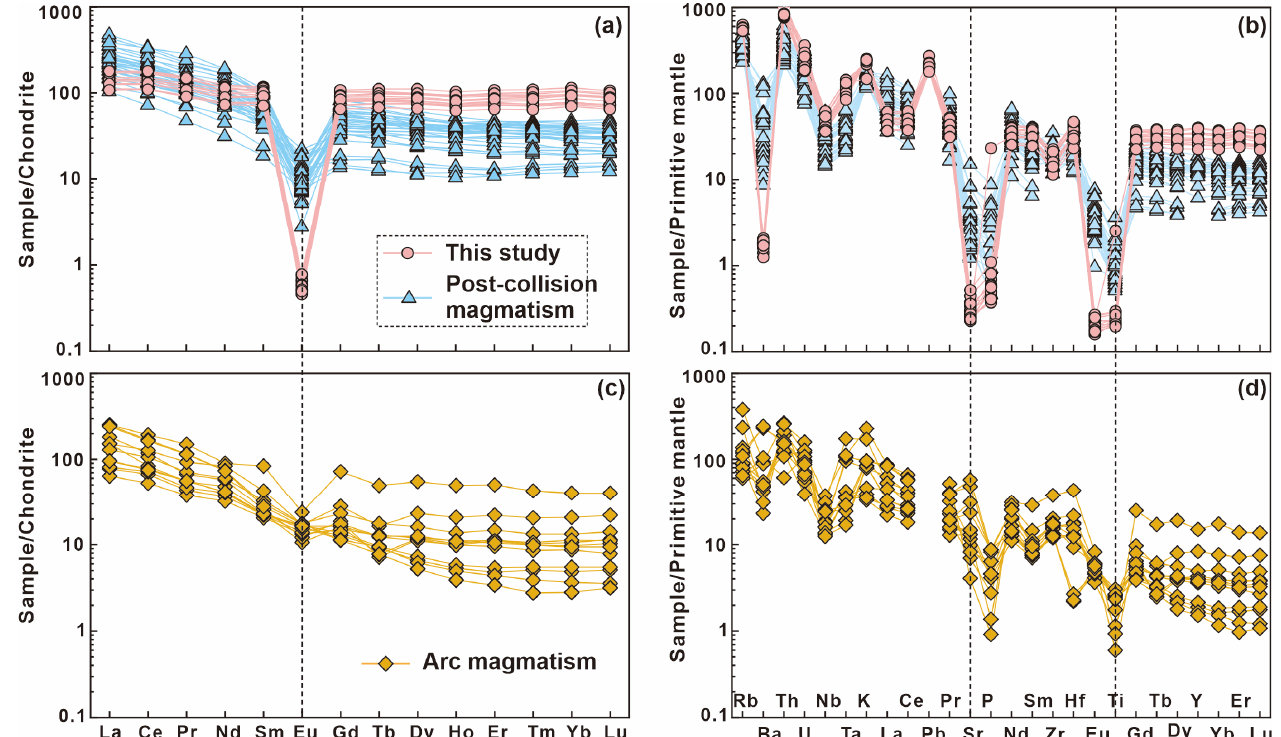
Figure 7. Chondrite-normalized rare earth element diagram ( a , c ) and primitive mantle-normalized trace elements diagram ( b , d ) for the granitoids from the middle Huaniushan arc. Chondrite and primitive mantle values from [60]. Geochemical data of post − collision and arc magmatism from [15,18,22–28].